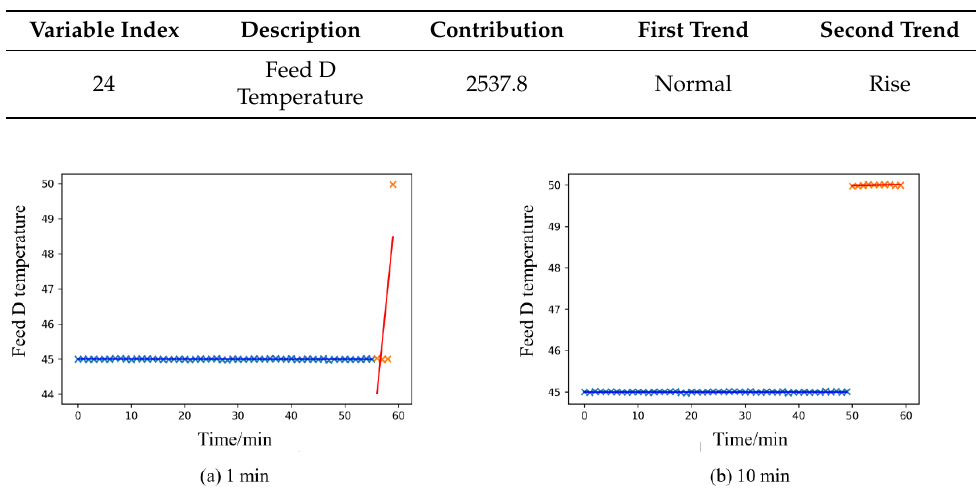
Figure 11. The linear fitting of variable 24 for Mode 2 fault 3: ( a ) 1 min; ( b ) 10 min.